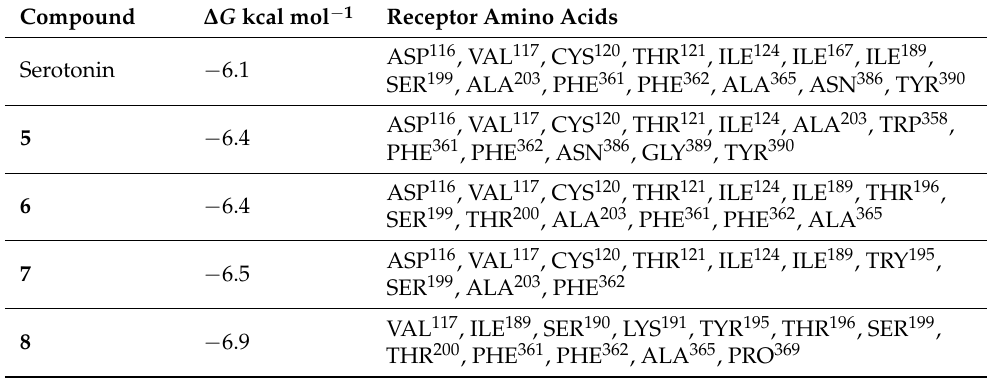
Table 3. Molecular docking parameters for the interaction of isolated indole compounds ( 5 – 8 ) with 5-HT 1A serotonin receptor.